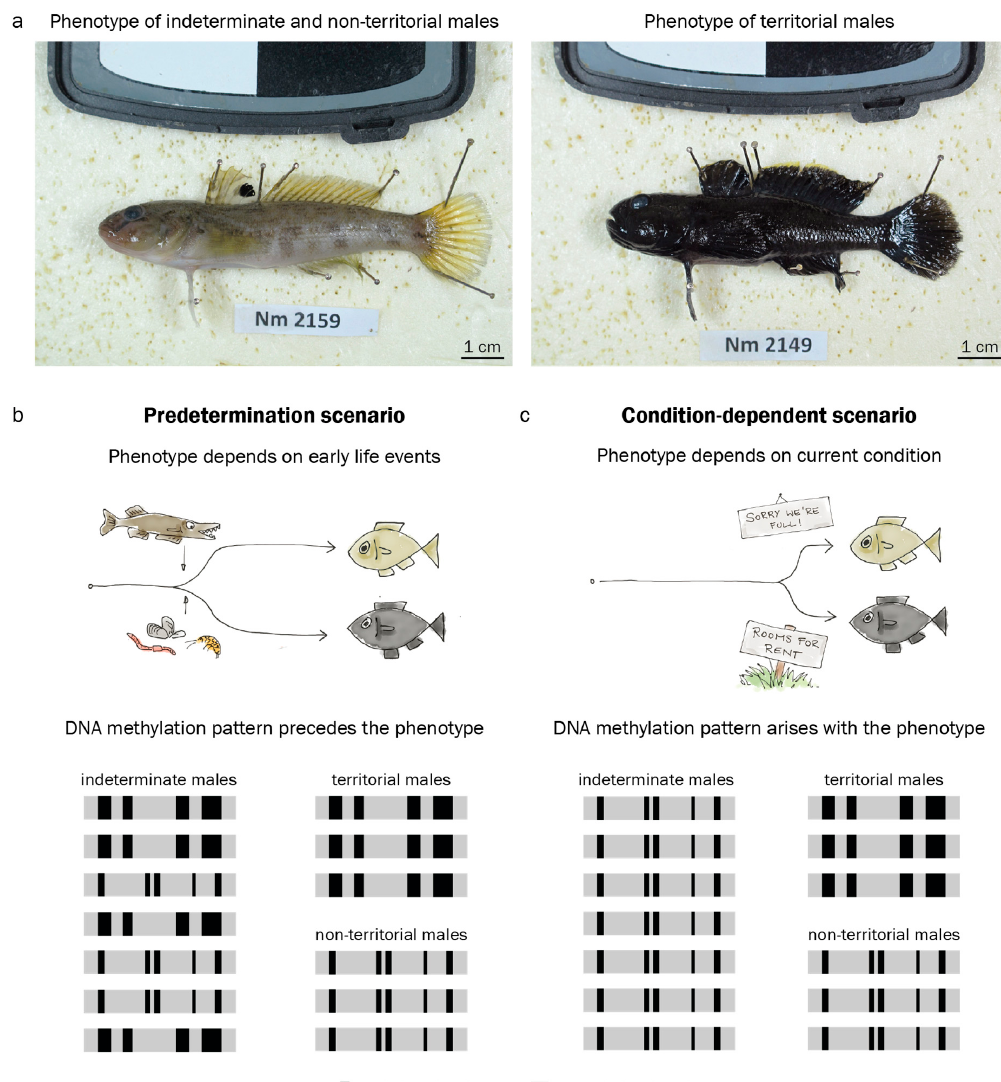
Figure 1. The male territorial phenotype in the round goby. ( a ). Usually, round goby males (and females) are light brown or grey. In the spawning season, territorial males develop a black coloration.